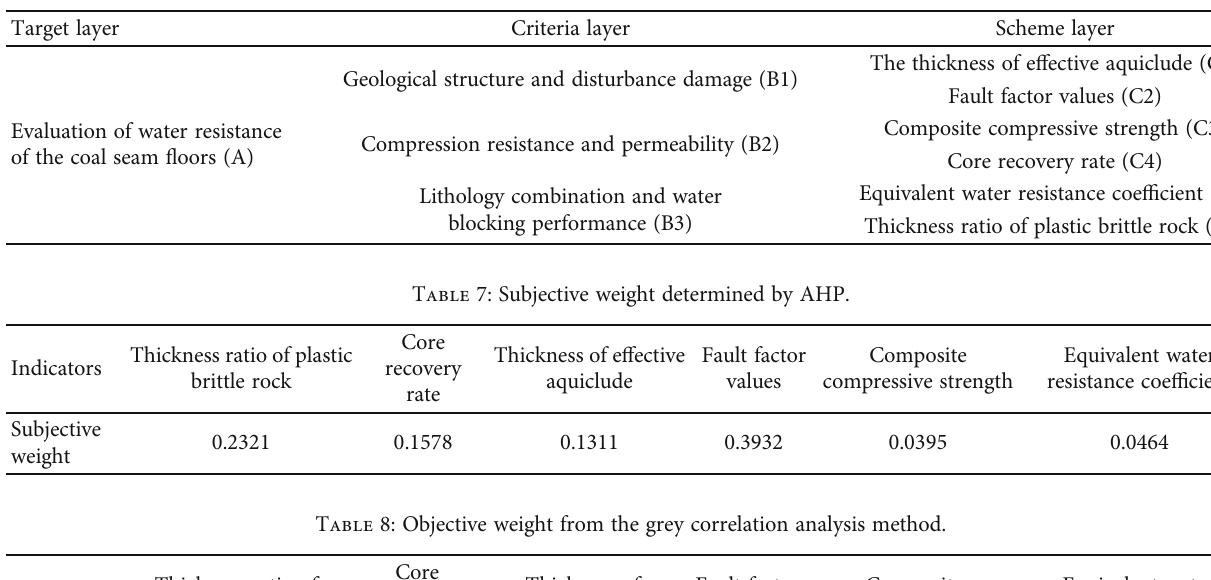
Table 6: Hierarchical structure performance index of aquiclude.